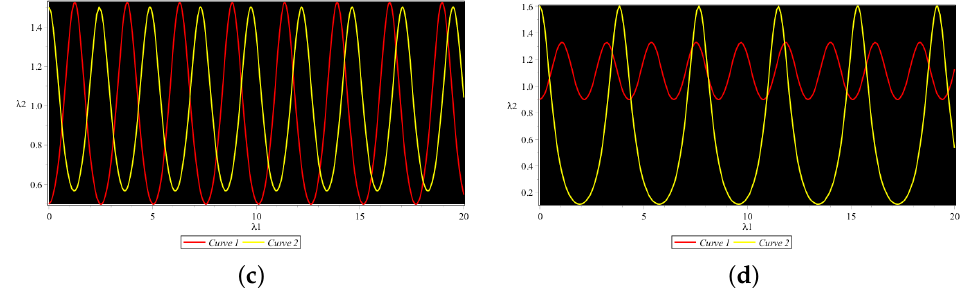
Figure 6. Sensitivity analysis at different initial conditions. ( a ) Sensitive visualization for curve 1 at (1.5,0.03) and curve 2 at (1.05,0.02). ( b ) Sensitive visualization for curve 1 at (1,0.03) and curve 2 at (1.04,0.02). ( c ) Sensitive visualization for curve 1 at (0.5,0.03) and curve 2 at (1.05,0.02). ( d ) Sensitive visualization for curve 1 at (0.9,0.03) and curve 2 at